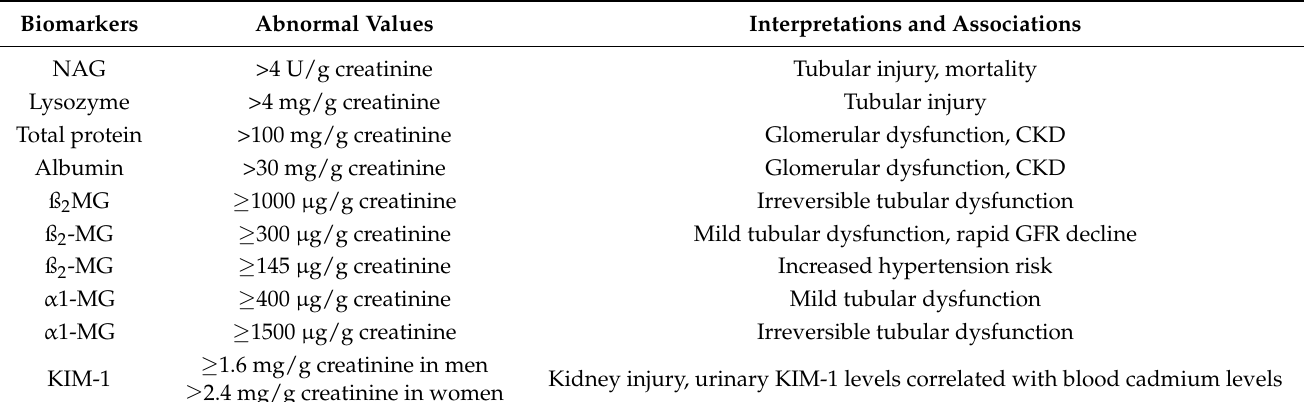
Table 3. Urinary biomarkers for the assessment of cadmium burden on the kidneys. Adapted from Satarug